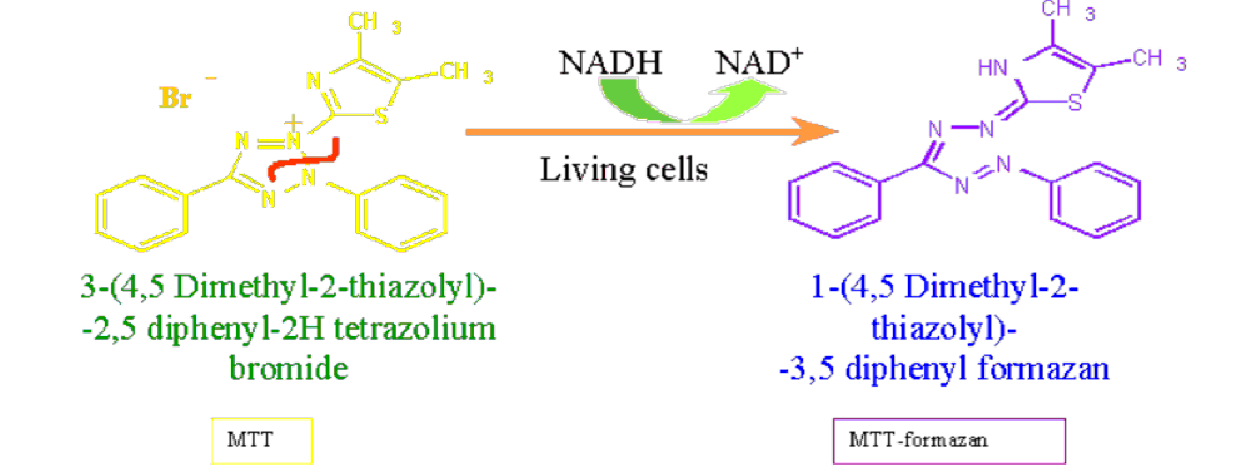
Fig. 6 Reduction of MTT in